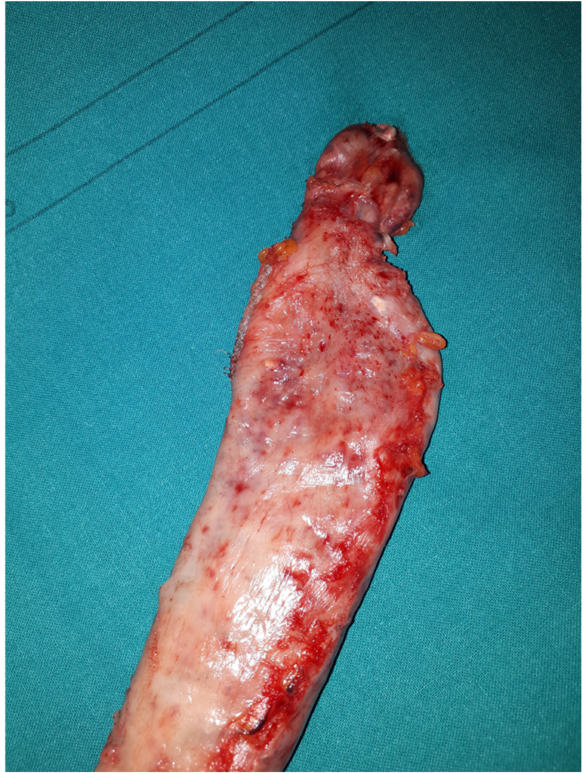
Figure 5. Gastric specimen with large diverticulum of the upper